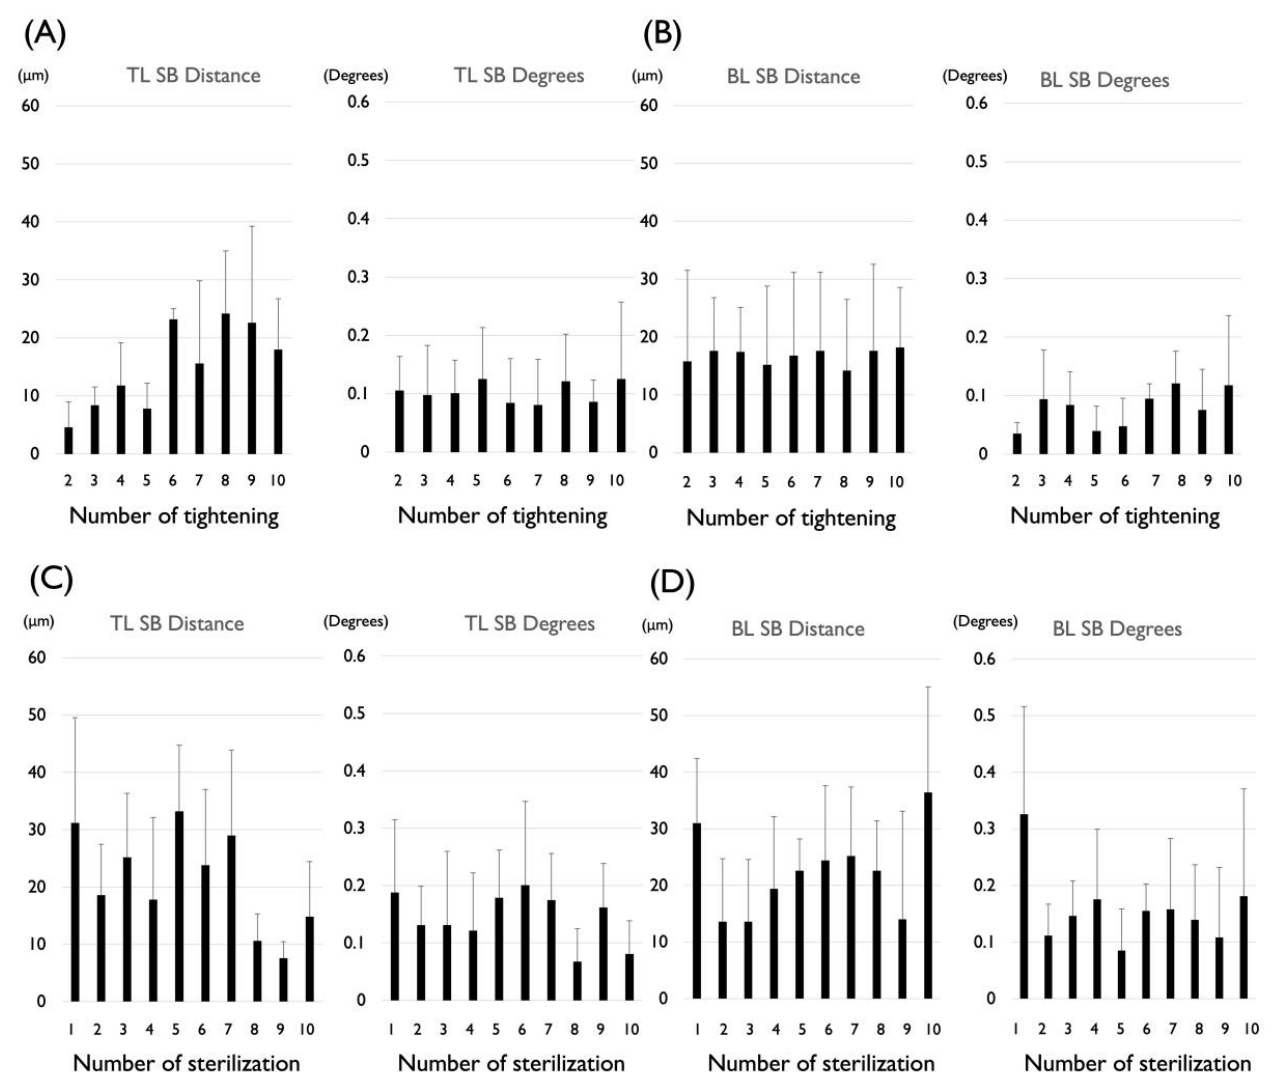
Figure 4. ( A ) The effect of repeated connection and disconnection on the deformation of the TL SBs. ( B ) The effect of repeated connection and disconnection on the deformation of the BL SBs. ( C ) The effect of autoclave treatment and repeated connection and disconnection on the deformation of the TL SBs. ( D ) The effect of autoclave treatment and repeated connection and disconnection on the deformation of the BL SBs.